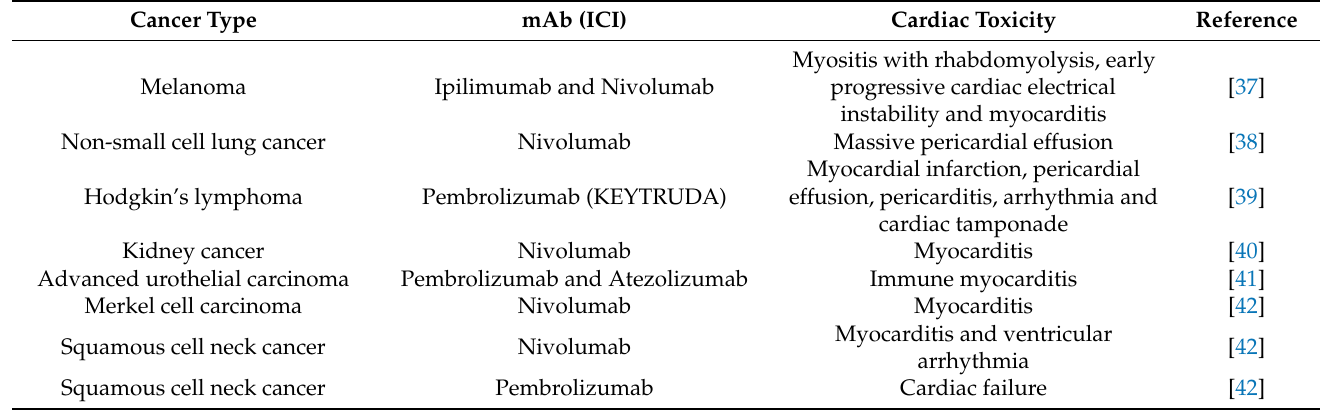
Table 1. Different ICI-induced Cardiac Toxicities in Different